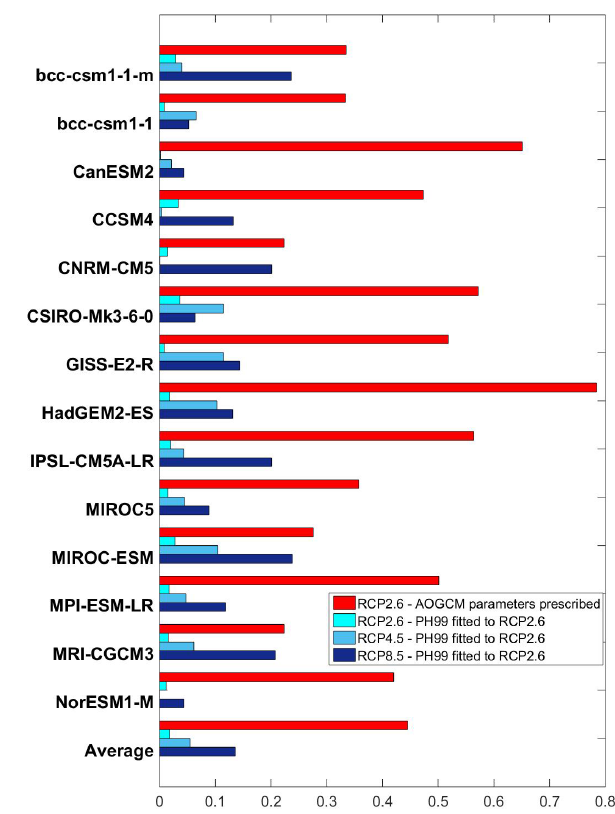
Figure 2. Modulus of deviations of GMT (K) mean values of PH99 over the period 2071–2100 from corresponding AOGCM means. The red bars show the deviations for RCP2.6 when α and µ are from Table 1 and not fitted. The cyan bars show the deviations in RCP2.6 when α and µ are fitted to the AOGCM’s RCP2.6 data. The light blue bars show the deviations for RCP4.5 when α and µ are kept at their RCP2.6-fitted values (validation). The dark blue bars show the deviations for RCP8.5 when α and µ are kept at their RCP2.6-fitted values (validation).